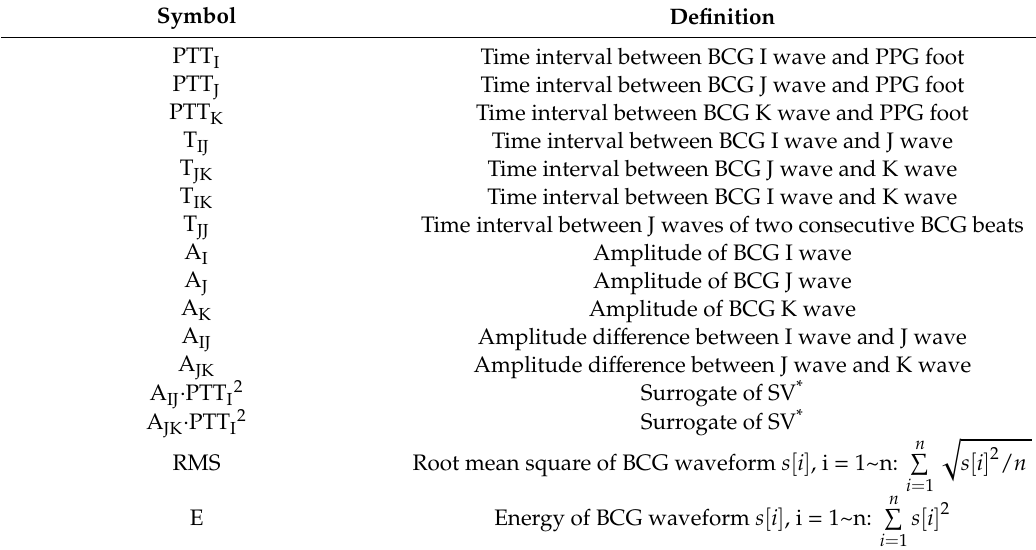
Table 1. Characteristic features extracted from the ballistocardiogram (BCG) in conjunction with the photoplethysmogram